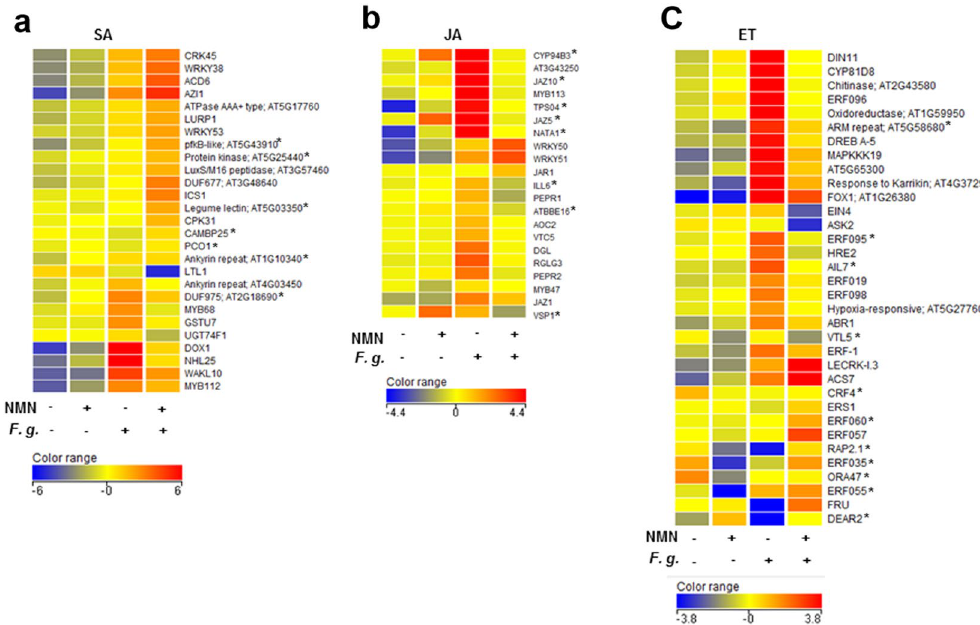
Figure 3. Hierarchical clustering of NMN-regulated genes with or without inoculation of F. graminearum in SA ( a ), JA ( b ), and ET ( c ) categories. SA-, JA- and ET-related genes were selected from NMN-induced or NMN-suppressed genes (FC > 2, P < 0.05) with or without inoculation, based on their GO term names. Then, hierarchical clustering analysis was performed using GeneSpring GX ver.12.5. The level of the bar colour indicates the magnitude of higher expression (red colour) or lower expression (blue colour) of each gene after normalization. F.g .; inoculated with Fusarium graminearum . Asterisk: Benjamini and Hochberg FDR was greater than